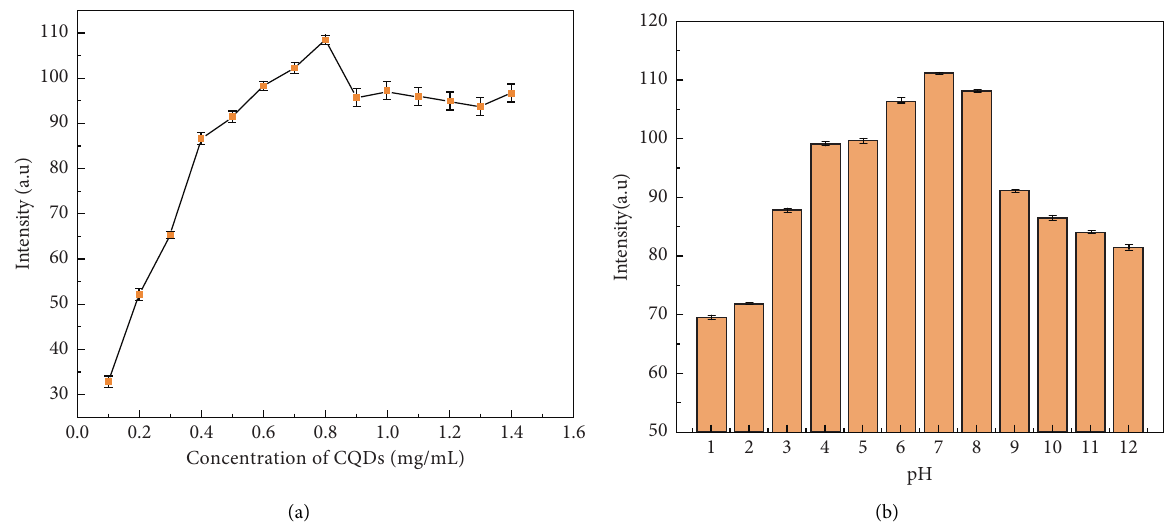
Figure 7: (a) FL intensity of CQDs at different concentrations; (b) FL intensity of CQDs at different